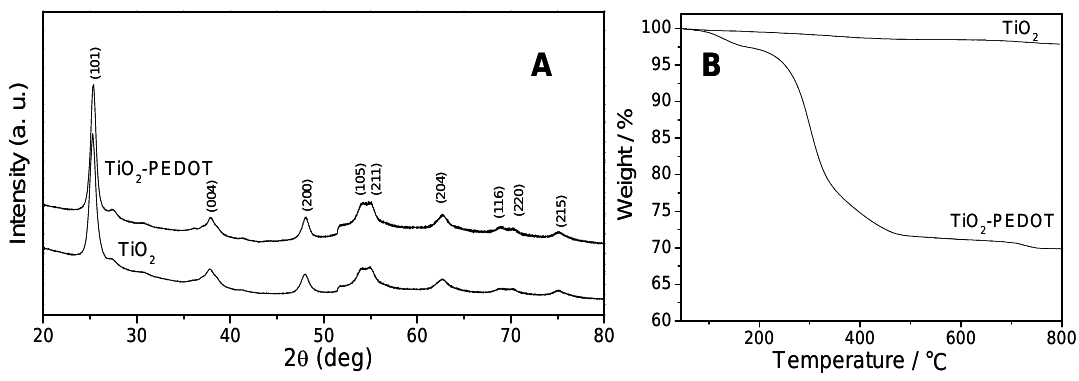
nanofibers and TiO -PEDOT nanocables. 2 2